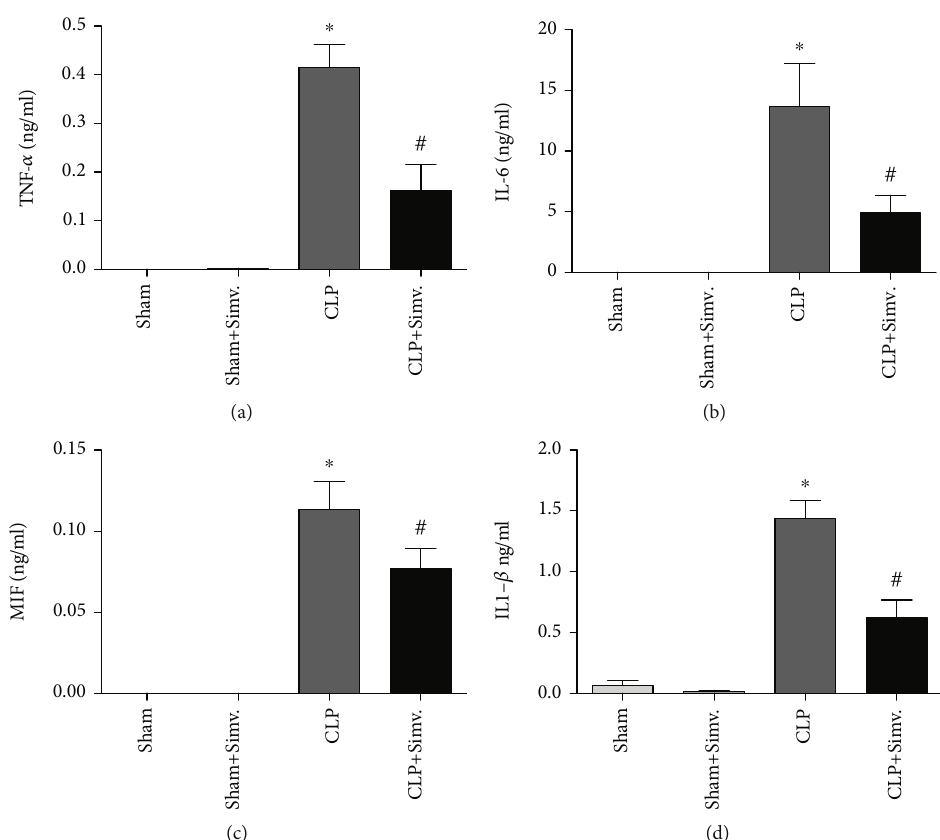
Figure 6: E ff ect of treatment with simvastatin in the levels of cytokines from peritoneal lavage supernatants of animals submitted to CLP. SW mice submitted to CLP, treated with simvastatin or untreated 6 hours after surgery, had their peritoneal cavity washed 24 hours after sepsis induction. The levels of TNF- α (a), IL-6 (b), IL-1 β (c), and MIF (d) were analyzed. Data represented as mean ± SEM of at least 6 animals. ∗ p < 0 : 05 , control vs. CLP+vehicle; # p < 0 : 05 , CLP+vehicle vs. CLP+ simvastatin.